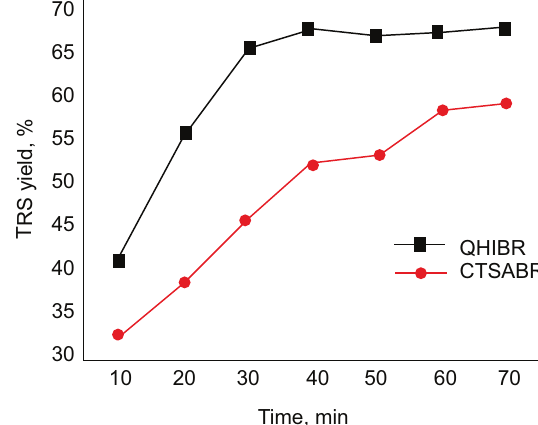
Figure 3. Effect of hydrolysis time on TRS yield